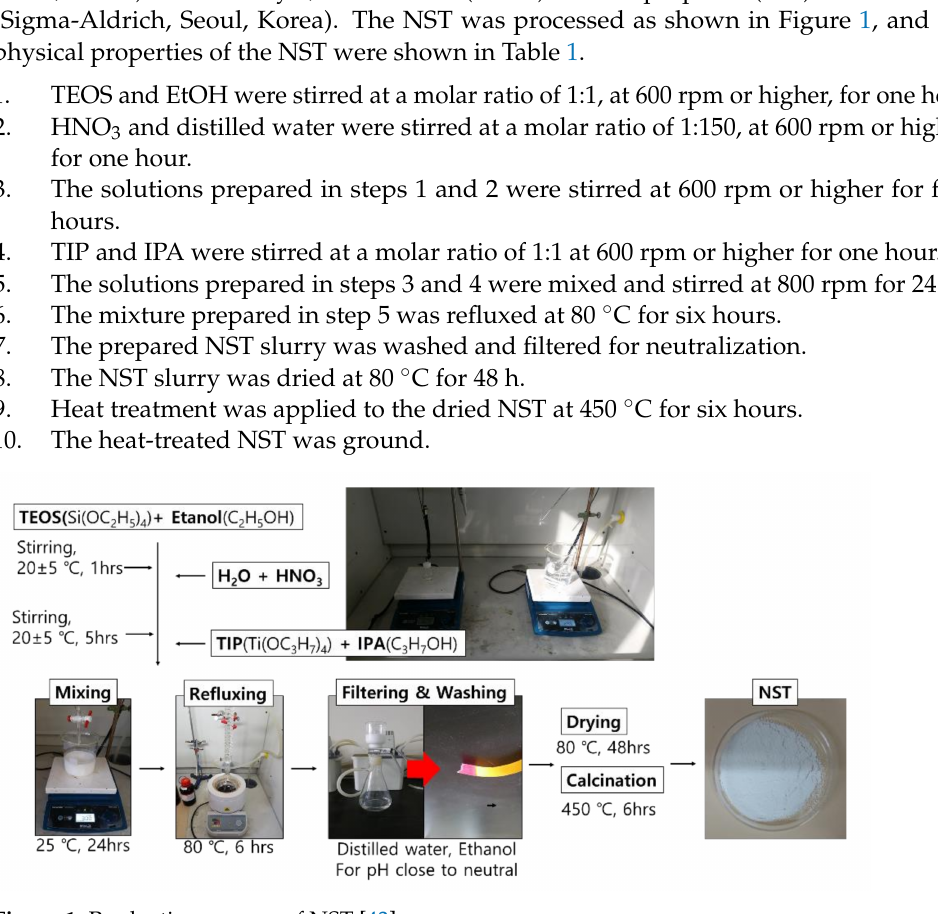
Figure 1. Production process of NST